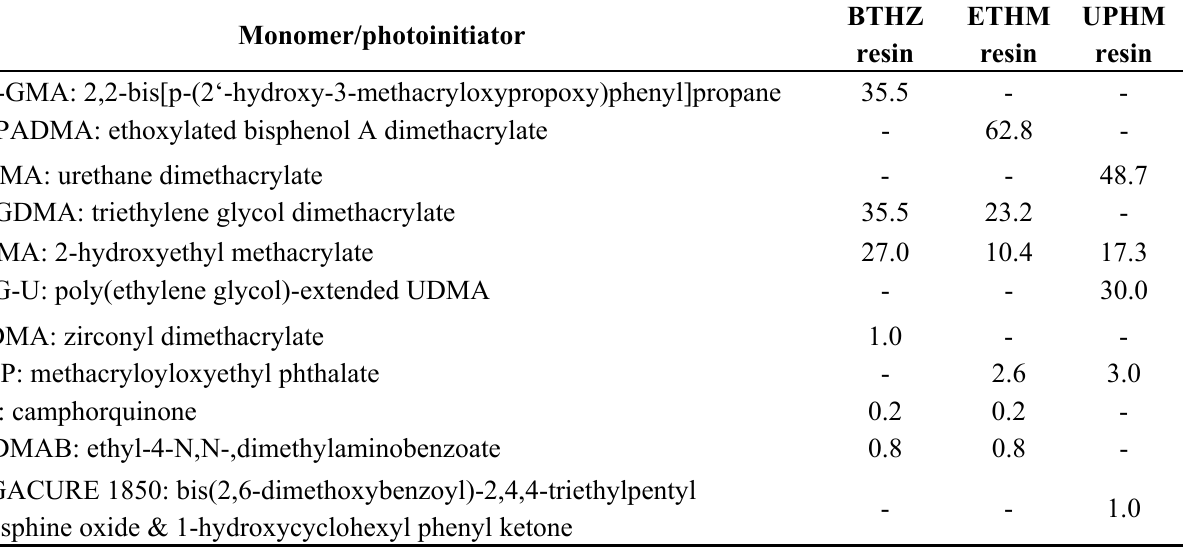
Table 2 . Composition (mass fraction %) of experimental resins evaluated in the